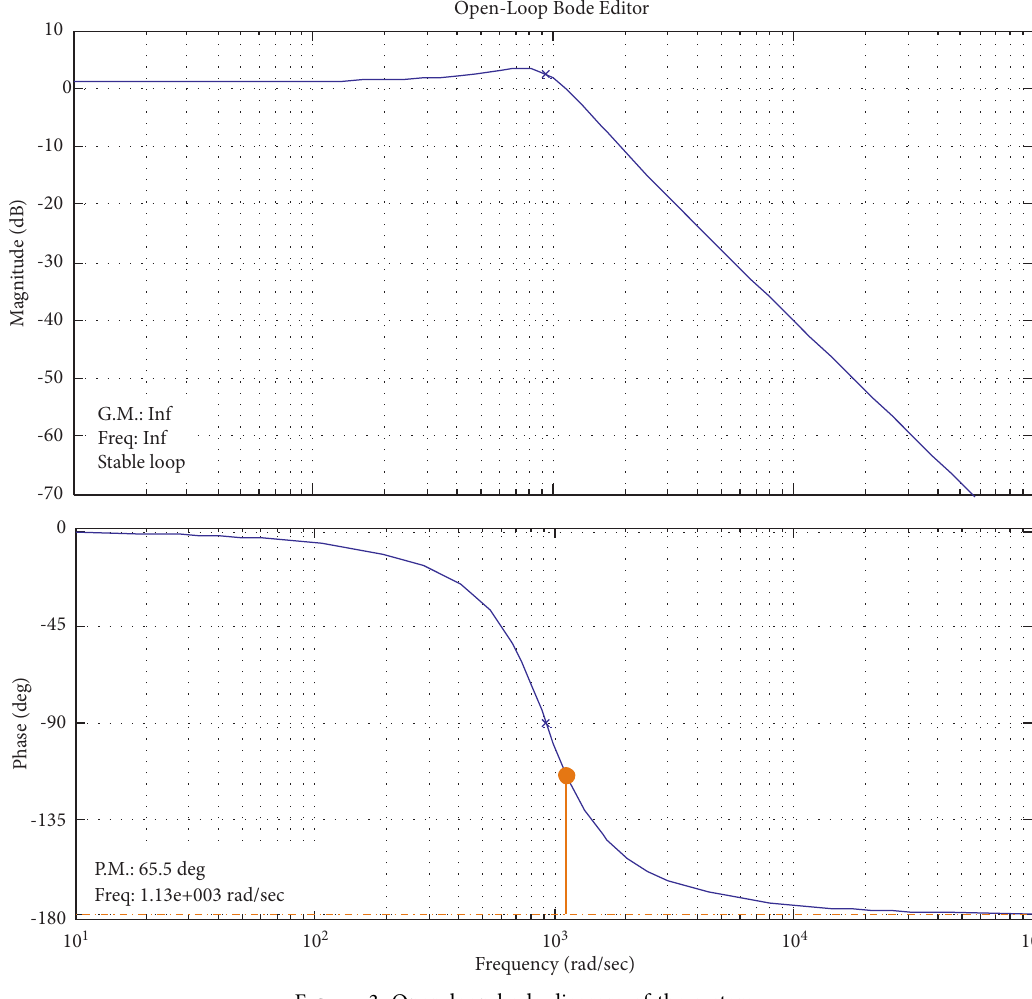
Figure 3: Open-loop bode diagram of the system.